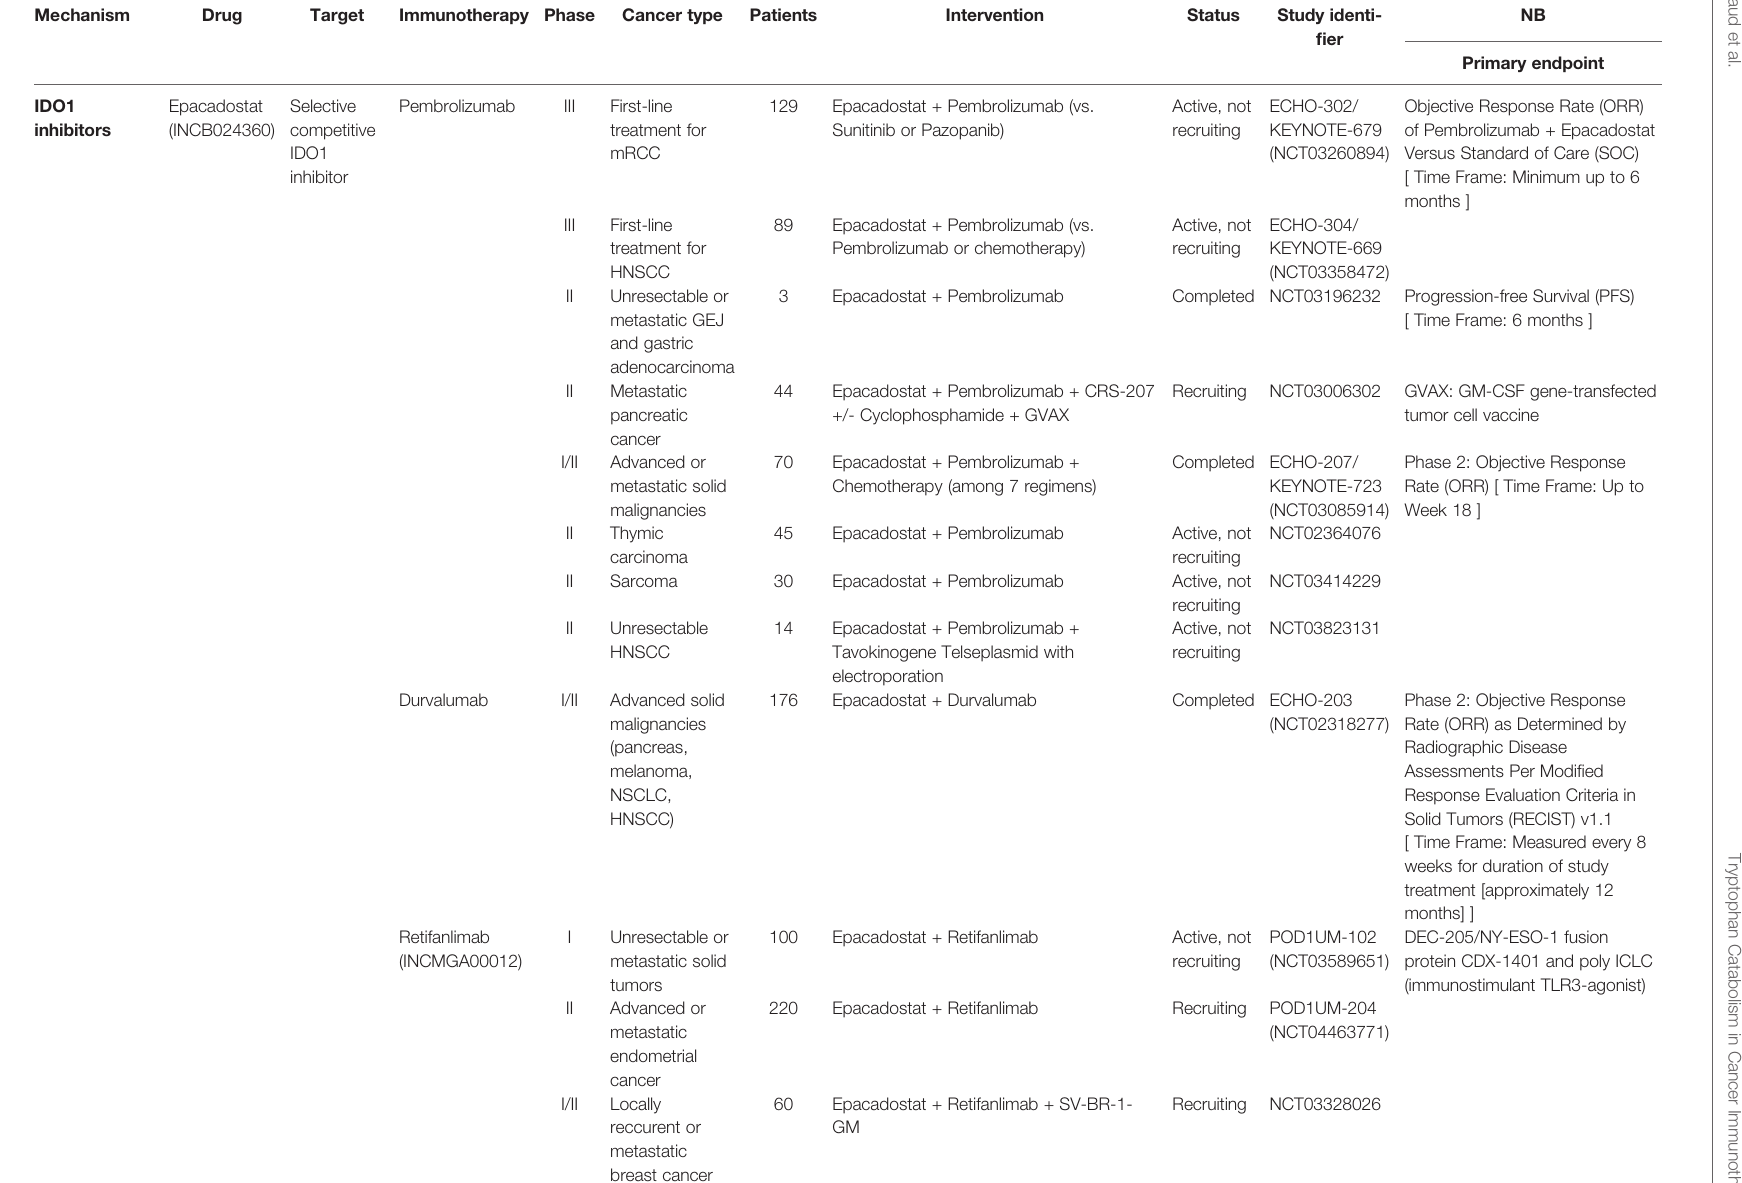
TABLE 3 | Ongoing clinical trials of Trp metabolism-targeting therapies in combination with